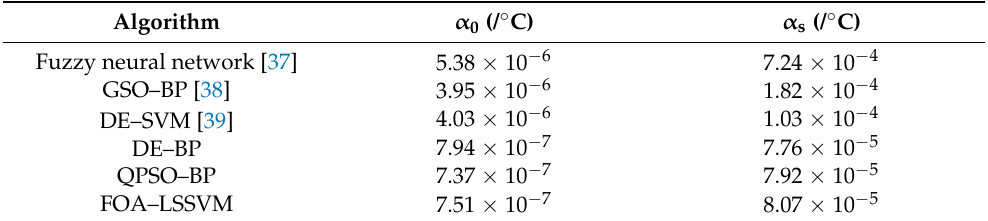
Table 7. Output accuracy of this paper’s algorithms compared with other algorithms in the